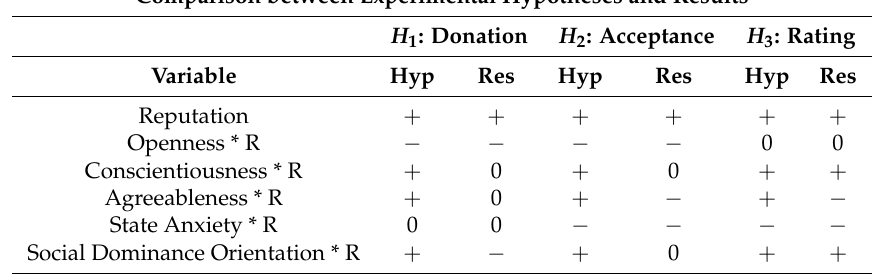
Table 7. Results and Experimental Hypotheses: in table is reported the comparison between the predictions derived by the existing literature, and the experimental results. Comparison between Experimental Hypotheses and Results H 1 : Donation H 2 : Acceptance H 3 :